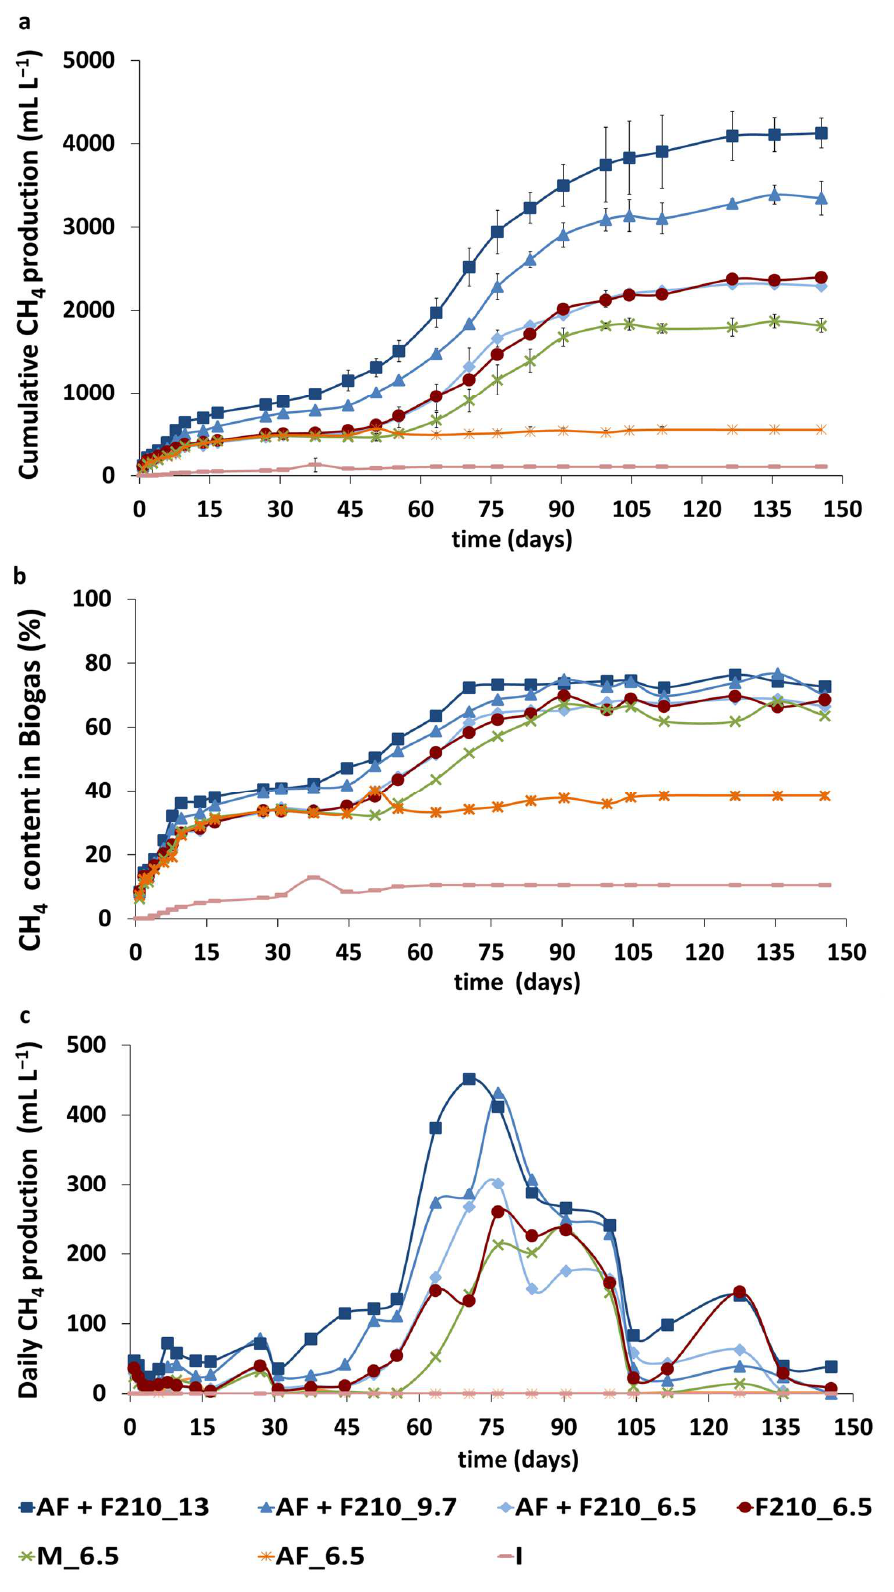
Figure 1. ( a ) Cumulative CH 4 production in all experimental tests (SD, values are also shown); ( b ) methane content in the biogas; ( c ) daily production of CH 4 (mL L −1 ). In ( b ) and ( c ) SD, values are less than 10%.